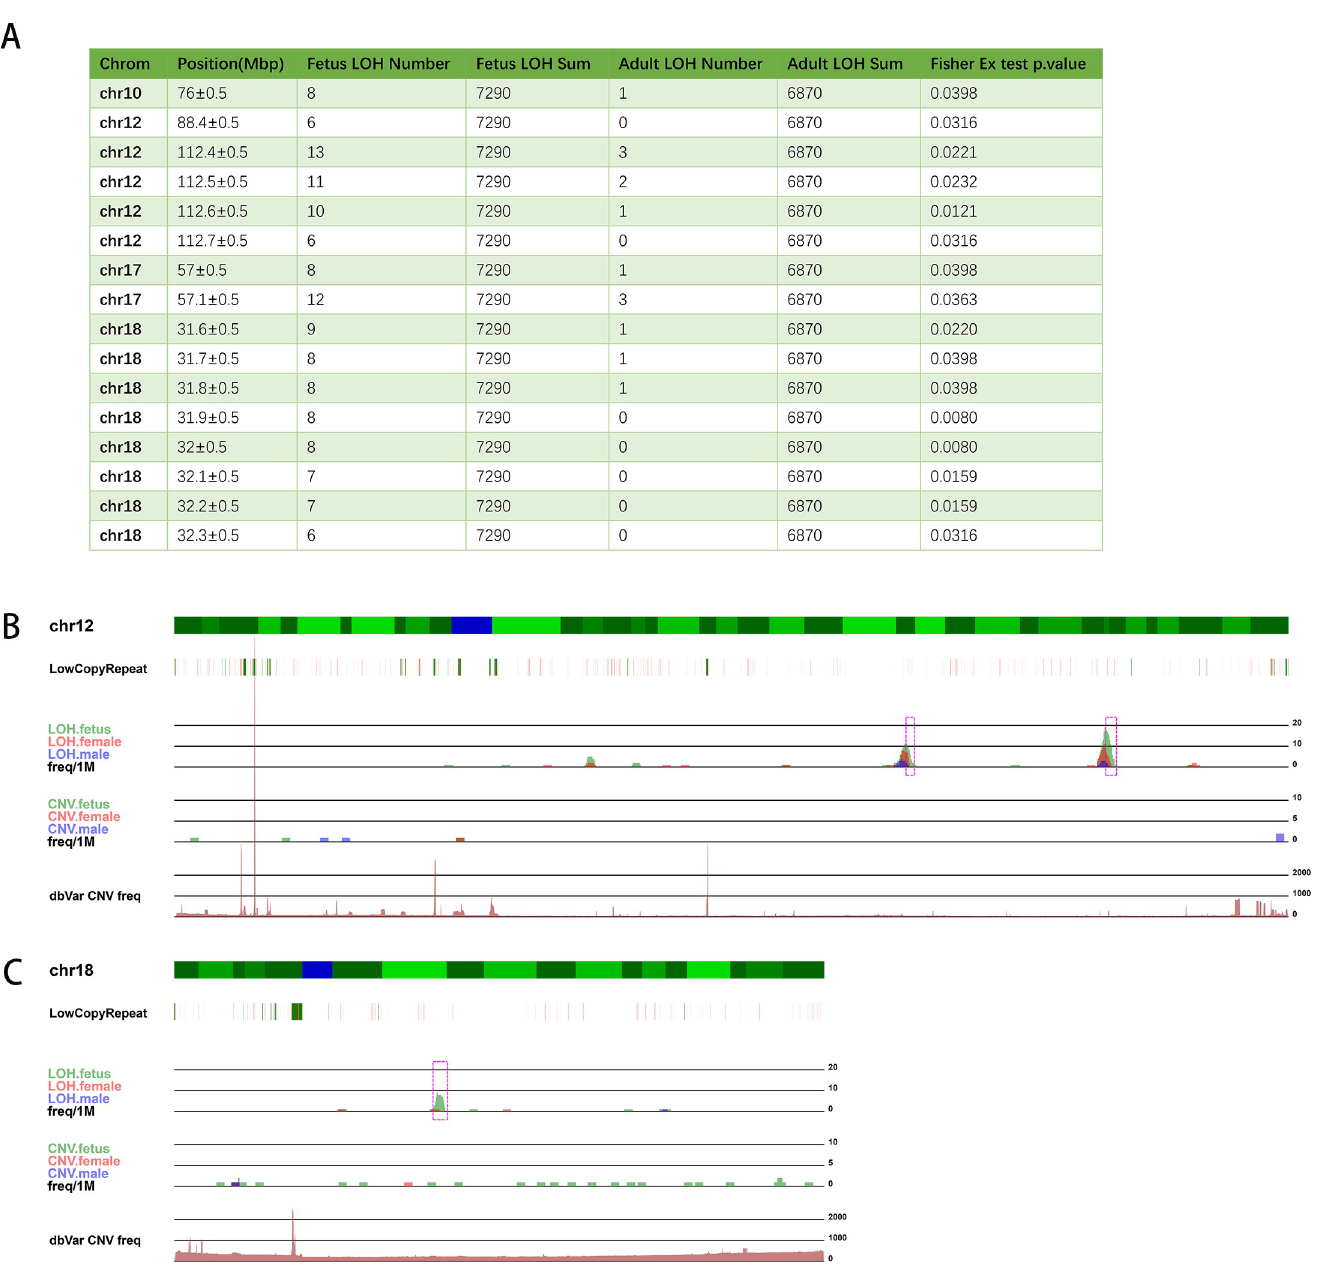
Fig 4. LOHs showed higher occur frequency in ART-aborted fetuses. (A) Chromosomal positions where high frequency of LOH occurred in aborted fetuses. (B) Visualization of the positions in chr12 and chr18 where LOHs were highly occurred in aborted